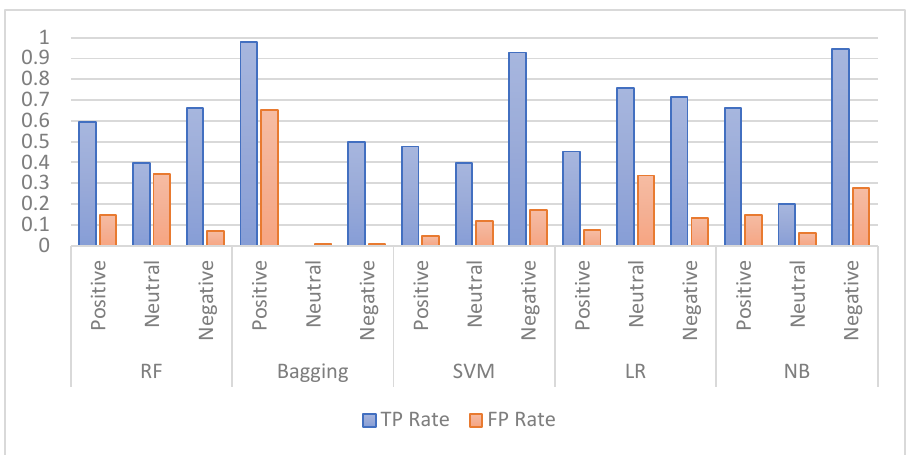
Figure 6. True-positive rate (TP Rate) and false-positive rate (FP Rate) of ML models with original sentiments using TF-IDF.